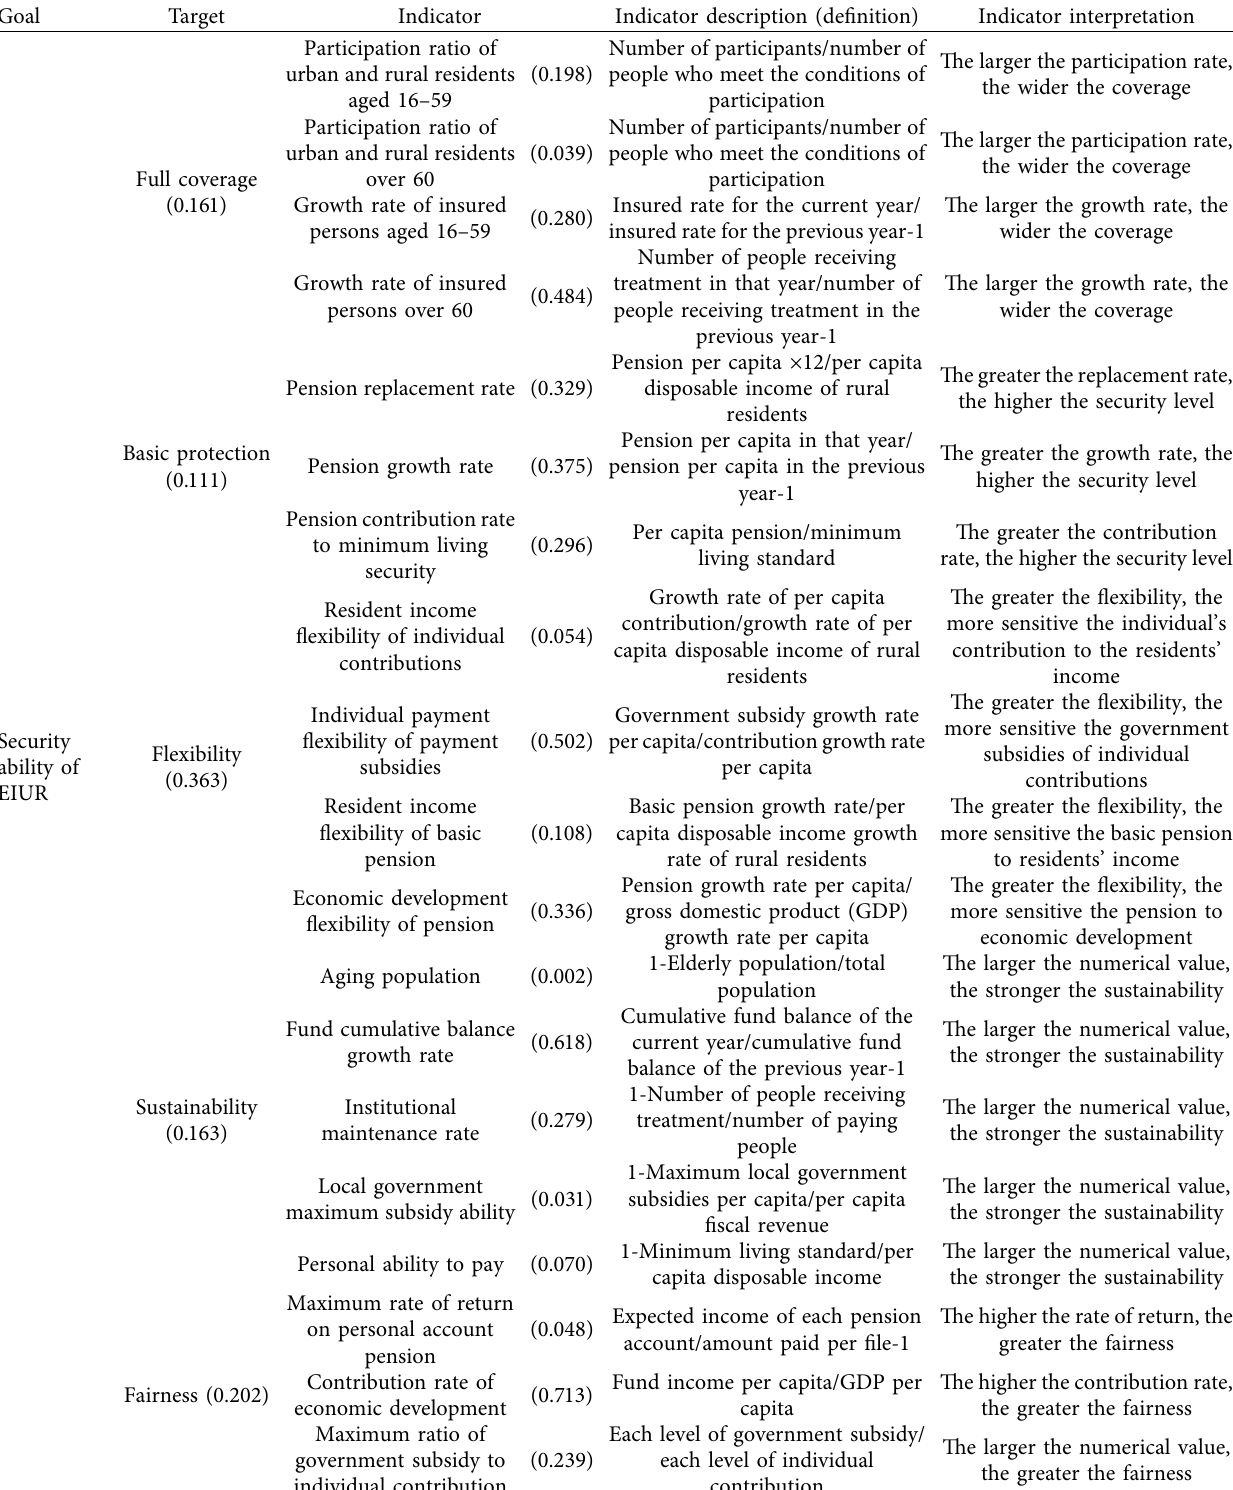
Table 1: Evaluation index system and weights of security ability of